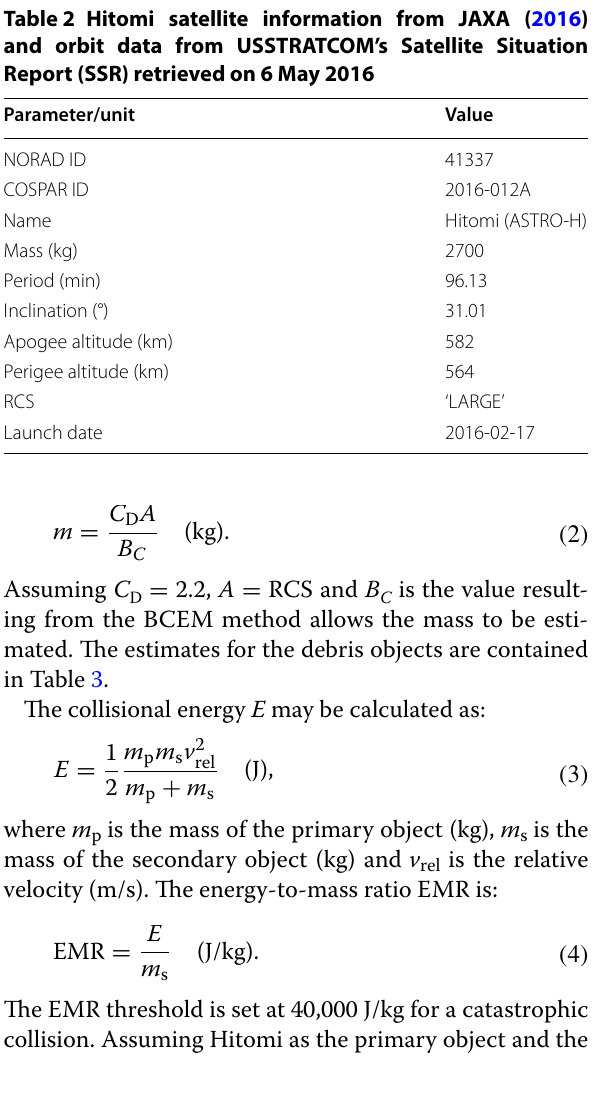
Table 3 Results of simulated fragmentation with Hitomi and debris. N C (> 0.1 ) —number of fragments larger than 10 cm generated from the conjunction NORAD